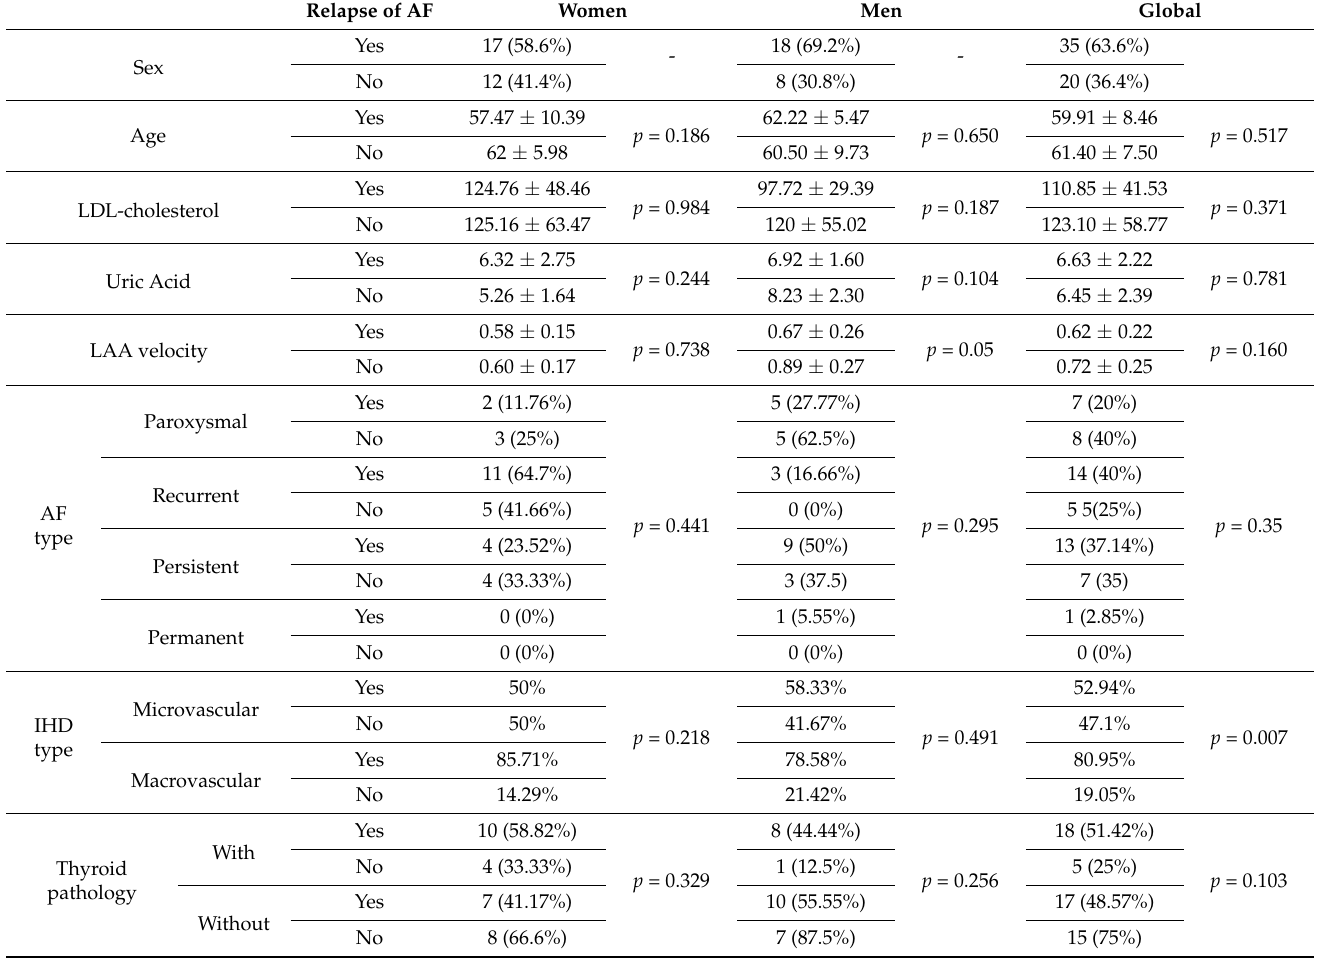
Figure 6. ( A ). Correlation between the number of antiarrhythmics used and the time elapsed until the ablation procedure was performed, estimated in years, in the global study population. ( B ). Correlation between the number of antiarrhythmics used and the time elapsed until the ablation procedure was performed, estimated in years, depending on the patient’s sex. Table 6. Risk factors for recurrence of atrial fibrillation 3 months after catheter